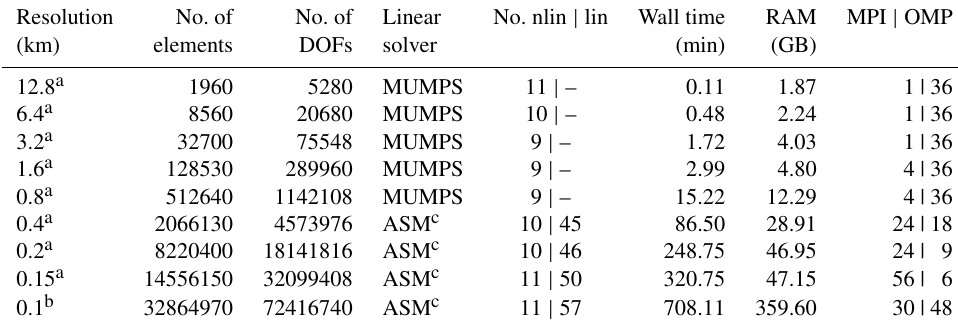
Table 1. Overview of mesh characteristics and consumed computational resources of the ice-stream region. Number of non-linear (nlin) iterations (damped Newton’s method), number of linear (lin) iterations, computational time and physical RAM usage are listed for E = 0 . 1, m = 1, FS and P1P1GLS strong; values do not vary much among other E and stress regime settings. Solver and cluster settings (OpenMP (OMP) shared-memory threads and distributed-memory tasks (MPI)) are kept constant between each resolution and stress regime. Compu- tational time includes the solver procedure (e.g. assembling the stiffness matrix, load vector) and outside routines (e.g. construction of mesh, saving results). Generally, COMSOL is run in hybrid mode, meaning the process is distributed to a user-defined number of OMP threads and MPI tasks. Without testing the performance thoroughly we achieve a good performance by OMP parallelism per physical node and MPI communication between physical nodes (the code is simply run in OMP mode if MPI is equal to one). The listed RAM usage refers to one MPI task. Please note that the cluster settings (MPI and OMP) have been chosen in a way that the job returns a solution within the cluster “wall time” but do not indicate any performance scaling.